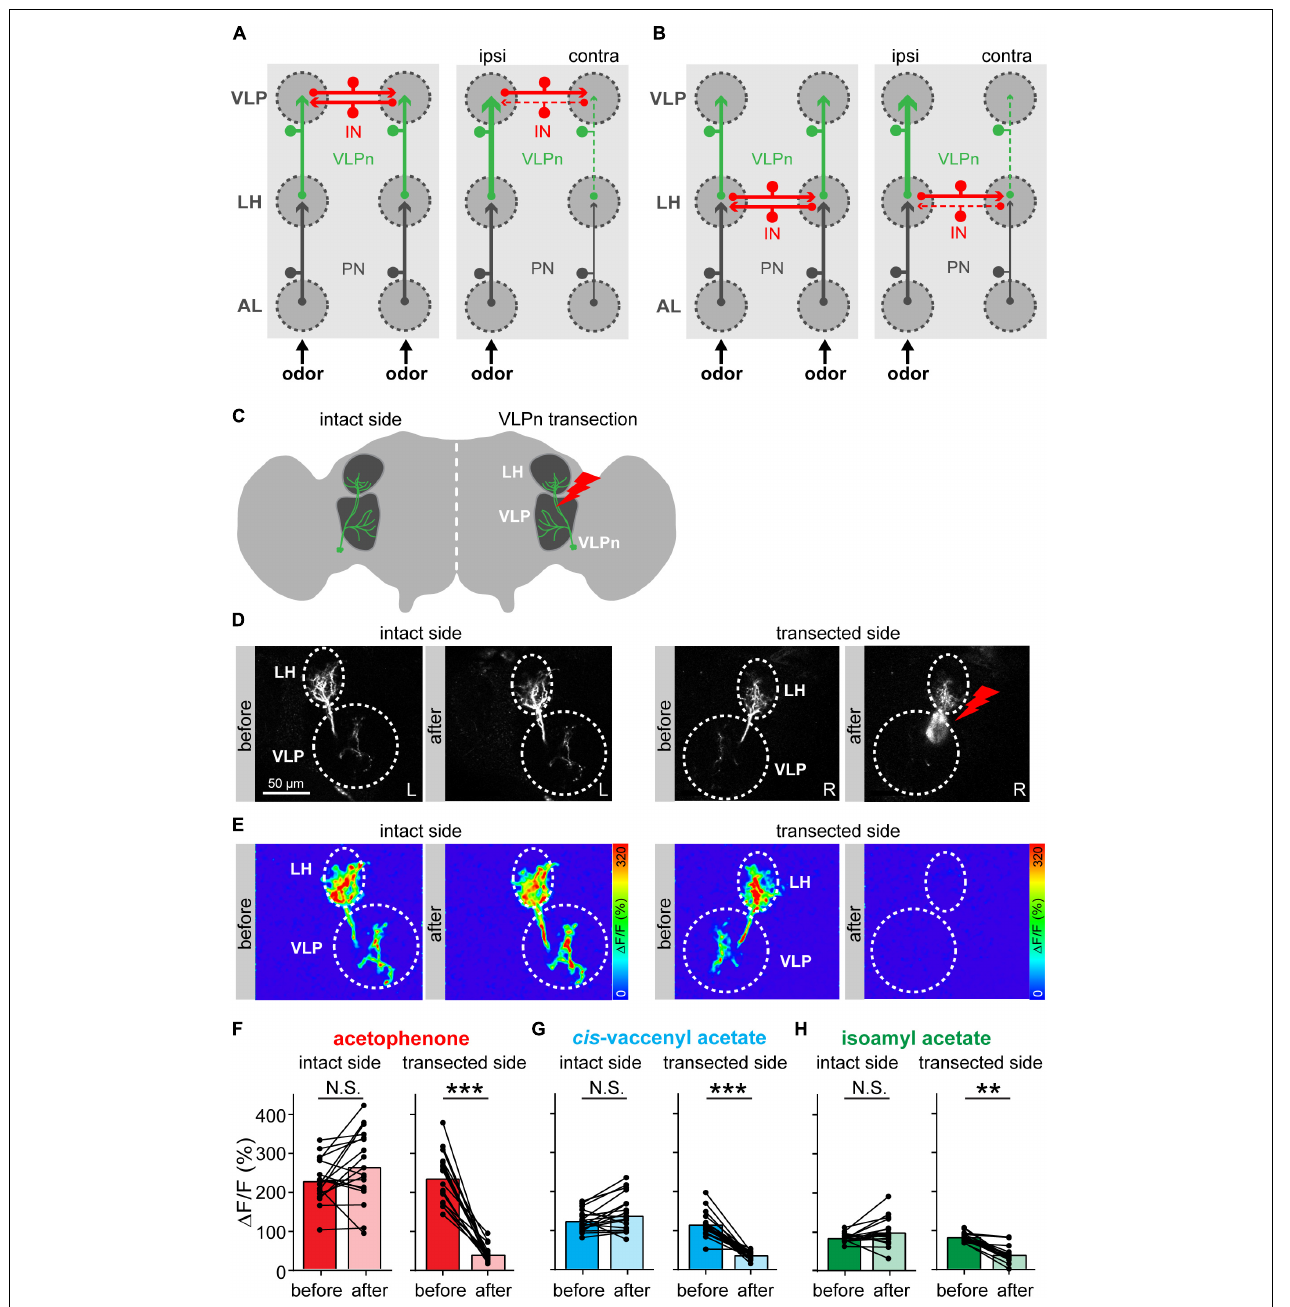
FIGURE 2 | Contralateral inhibition takes place presynaptically to VLPn. (A,B) Two proposed models for the contralateral suppression in VLPn. In both models, projection neurons (PNs, black) activate downstream the VLPn (green). Presynaptic input is represented by an arrow, postsynapses are indicated by a small circle. In the VLP inhibition model (A) , inhibitory neurons (INs, red) connect the VLPn of both sides at their postsynaptic sites (i.e., within the VLP neuropil). In this case, activation of VLPn on one side would be required to induce inhibition in the contralateral VLPn. In the LH inhibition model (B) , the IN (red) connects the VLPn of both sides at their presynaptic sites (i.e., in the LH). Here, activation of VLPn would not be required to cause contralateral inhibition. In both models (A,B) , the strength of activation is represented by the line size; solid lines represent active neurons and dashed lines represent not activated and/or inhibited neurons. (C) Schematic drawing of the laser transection experiment. VLPn were transected only on one brain side, while leaving VLPn on the contralateral side intact. This allowed us to abolish any odor-evoked responses of VLPn in the transected side. (D) Gray-scale images of VLPn expressing GCaMP6f under control of NP5194-Gal4 before and after laser transection in the intact and transected side. Scale bar = 50 µ m. (E) Examples of false-color coded images of odor-induced Ca 2 + signals corresponding to each gray-scale image shown in D from a representative fly. (F–H) Paired comparisons of the calcium signals before and after the transection of VLPn across different flies. Odor-evoked Ca 2 + signals were recorded and analyzed for both sides (i.e., intact and transected side). Ca 2 + signals were abolished in VLPn in the transected side after transection. The intact brain hemisphere shows a slight, but not significant, increase prior to the transection. Dots and lines represent individual flies, bars represent the mean ( n = 18; ∗ p < 0.05; ∗∗ p < 0.01; ∗∗∗ p < 0.001, paired t -test).